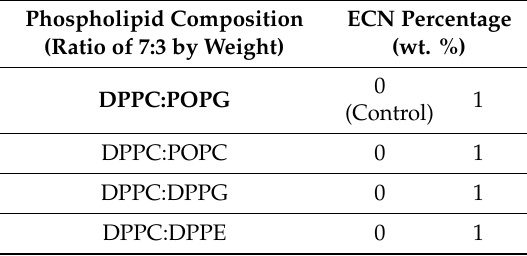
Table 1. The table lists the samples that have been used in the study. The phospholipid mixtures were taken in the ratio of 7:3 by weight, keeping the percentage of DPPC maximum. The samples with 1 weight % ECN were compared with their counterpart(control)that had no ECN in the mixture. Phospholipid Composition ECN Percentage (Ratio of 7:3 by Weight) (wt. %) 0 DPPC:POPG 1 (Control)